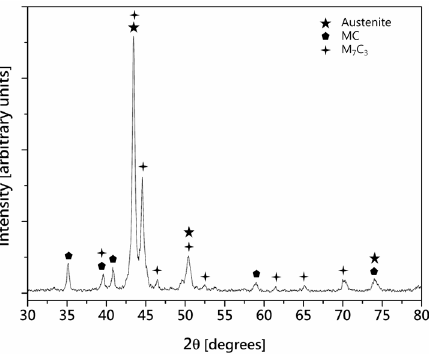
Figure 4. X-ray Diffraction (XRD) patterns of the hardfacing on the resistant-side